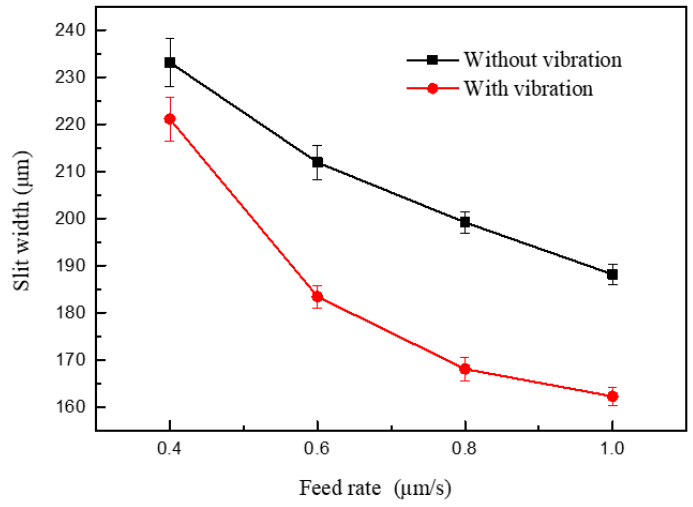
Figure 19. Variation in the slit width in relation to feed rate.